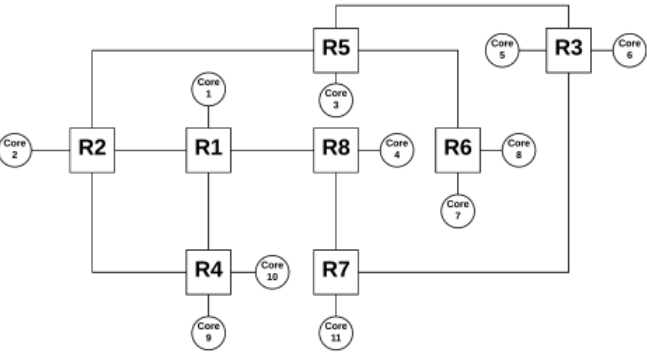
Figure 3. Example of an irregular topology using the proposed architecture.